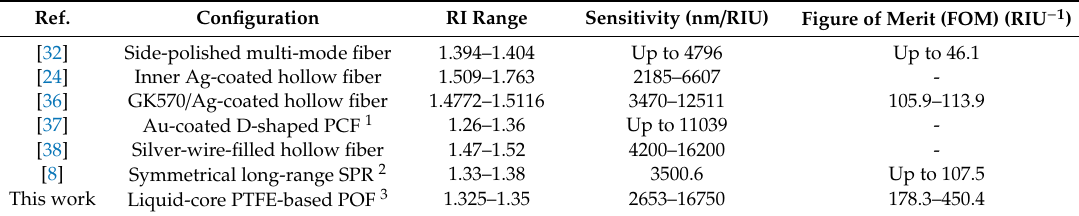
Table 2. Comparison of the sensing performance of the proposed sensor with other designs. Ref. Figure of Merit (FOM) (RIU − 1